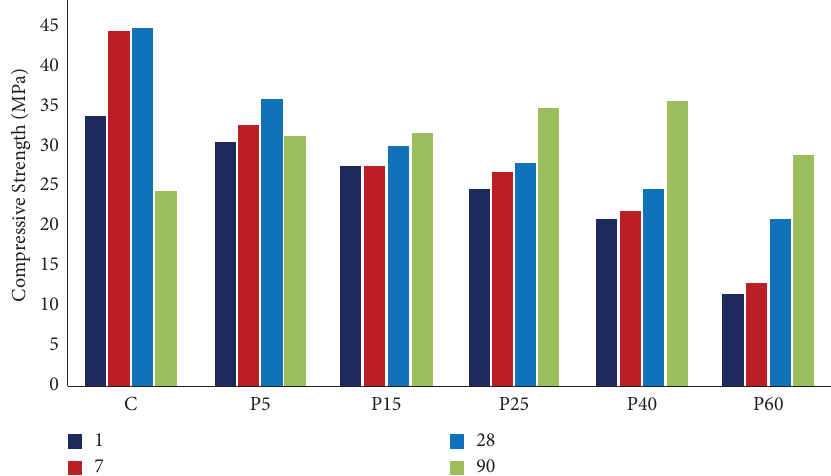
Figure 2: Compressive strength of the pumice mixtures at the age of 1 to